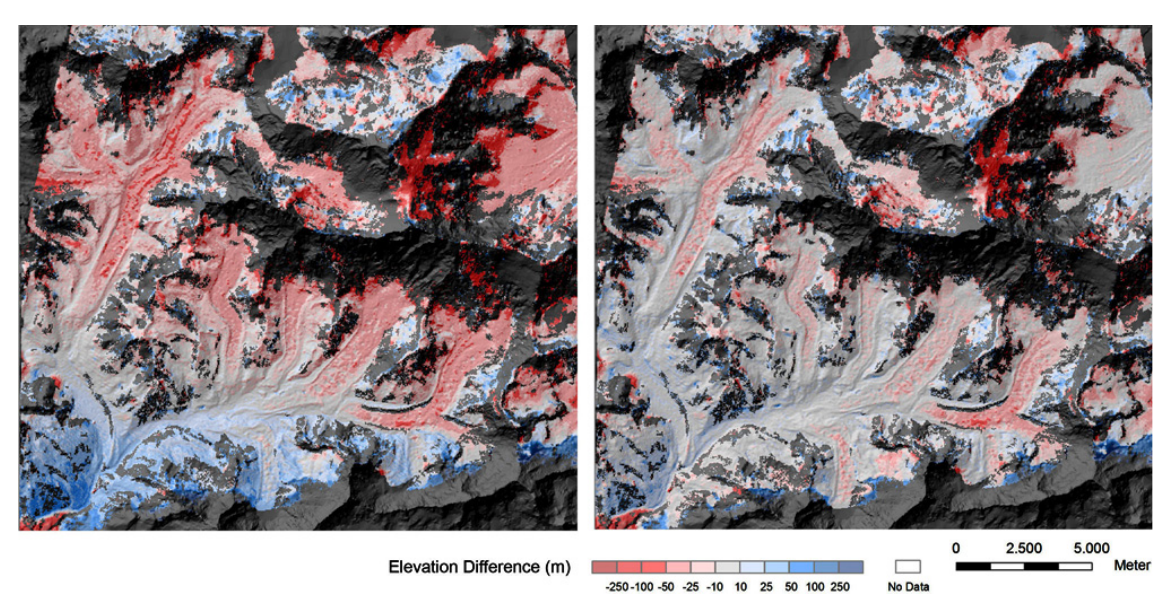
Fig. 2. Elevation difference of 1970 Corona and 2007 Cartosat DTM before (left) and after adjustment (right). Graz (RSG, http://dib.joanneum.at/rsg/) 6.13 for processing Corona, PCI Geomatica OrthoEngine 10.2 for Cartosat, and Leica Photogrammetry Suite (LPS) 9.1 for the aerial